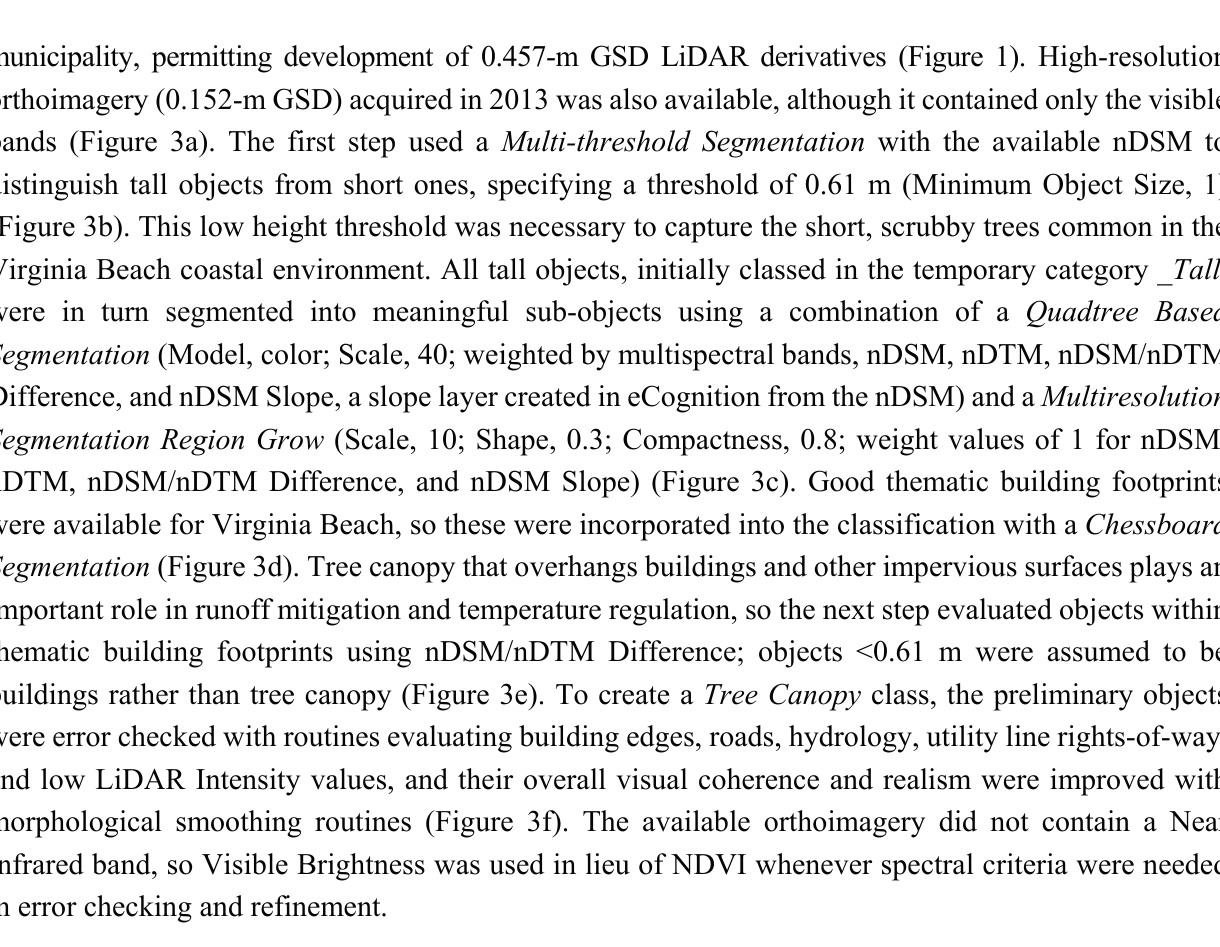
Figure 2. Processing workflow for tree canopy mapping, from initial segmentation